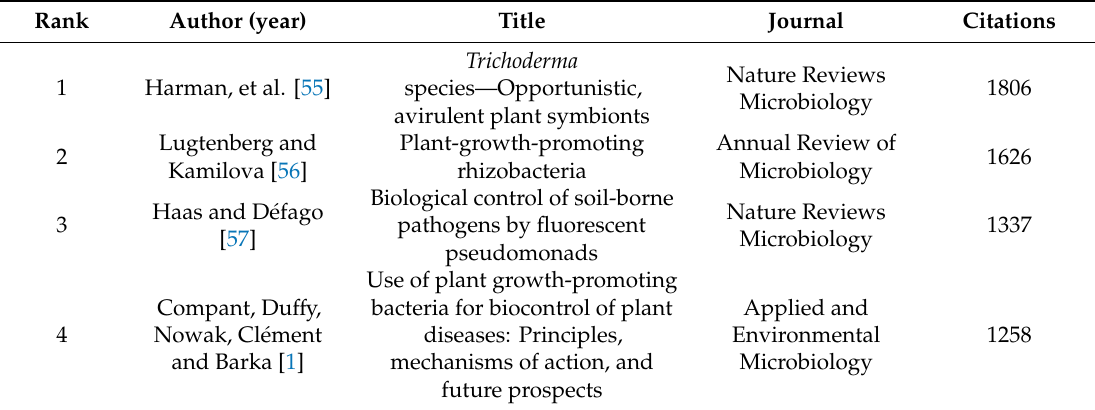
Table 2. The 15 most-cited articles for “biological pest control” and “microorganism” from 1973 to 2020 (18